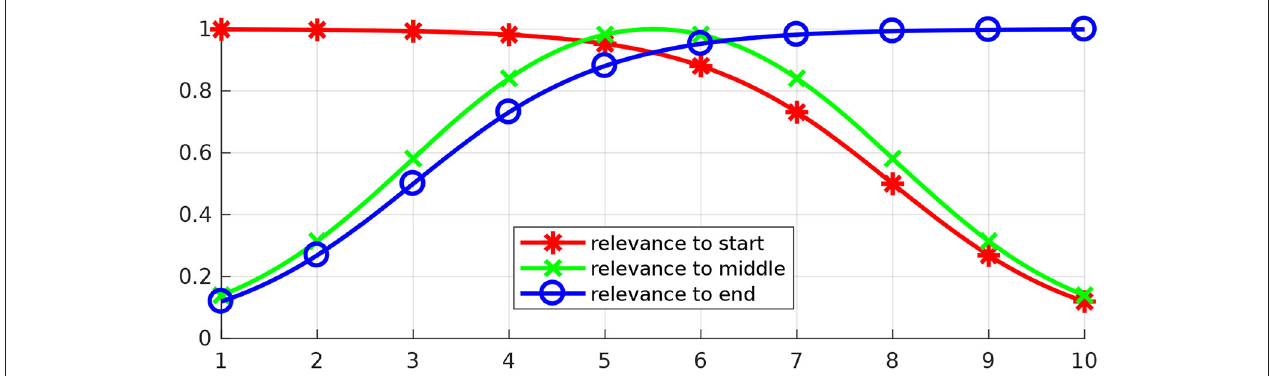
FIGURE 5 | Three examples of relevance functions. Let us assume that our goal is to optimize a certain movement with respect to an objective at the beginning of the movement, an objective in the middle and an objective in the end. Let us further assume that the movement to be optimized can be determined by 10 parameters and that the first parameters (close to 1) have higher influence over the beginning of the movement, while the last ones (close to 10) have higher influence over the end. The image depicts potentially suitable relevance functions for each of the objectives in this